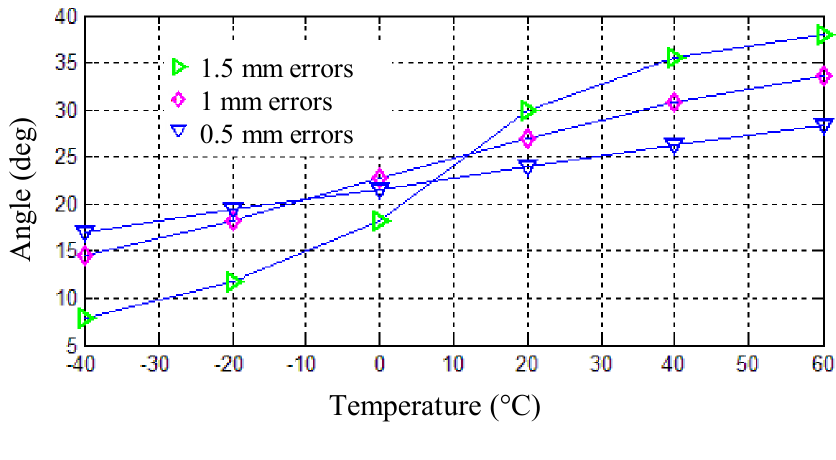
Figure 9. Position shifts of one antinode axis induced by geometry